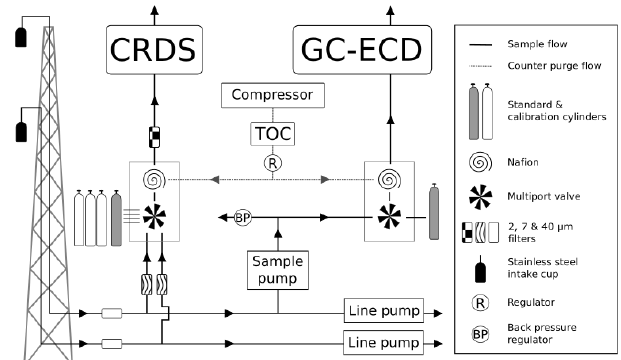
Figure 2. A generalized schematic showing the initial Bilsdale and Heathfield site set-up of the cavity ring-down spectrometer (CRDS) and the gas chromatograph–electron capture detector (GC–ECD) including the dry gas generator (TOC) and back pressure regulator (BP). Note that Bilsdale has three inlets, while Heathfield has only two as shown here. The Nafion ® drying system located downstream of the CRDS multiport valve was removed at both sites in 2015. Black arrows and lines show the direction of sample, standard and calibration gas flow. Grey dashed lines and arrows show the flow path of the Nafion ® counter purge